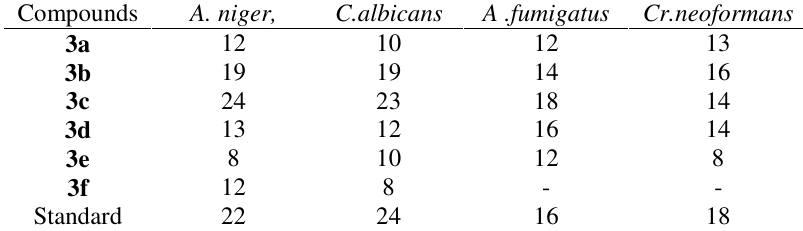
Table 3. Antifungal activity of the compounds (3a-3f) Compounds A. niger,